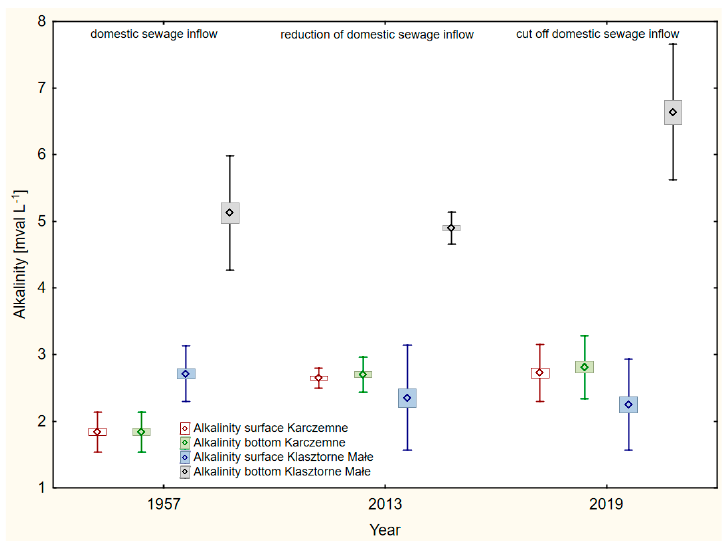
Figure 9. Mean annual values of alkalinity (box ± SEM; whisker plots ± SD) in the water of Karczemne and Klasztorne Ma ł e lakes.